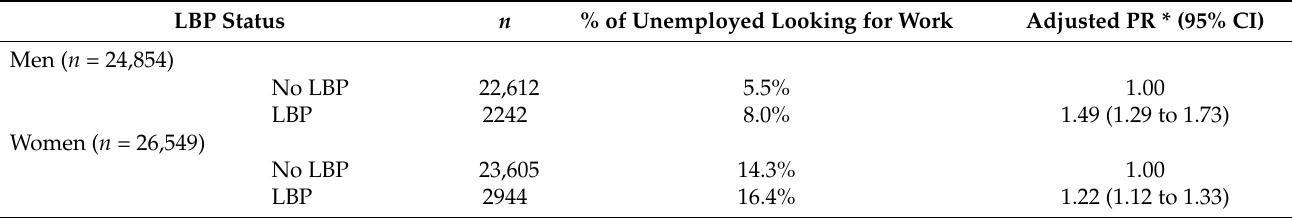
Table 3. Adjusted prevalence ratios for unemployed looking for work according to presence or absence of self-reported low back pain, by